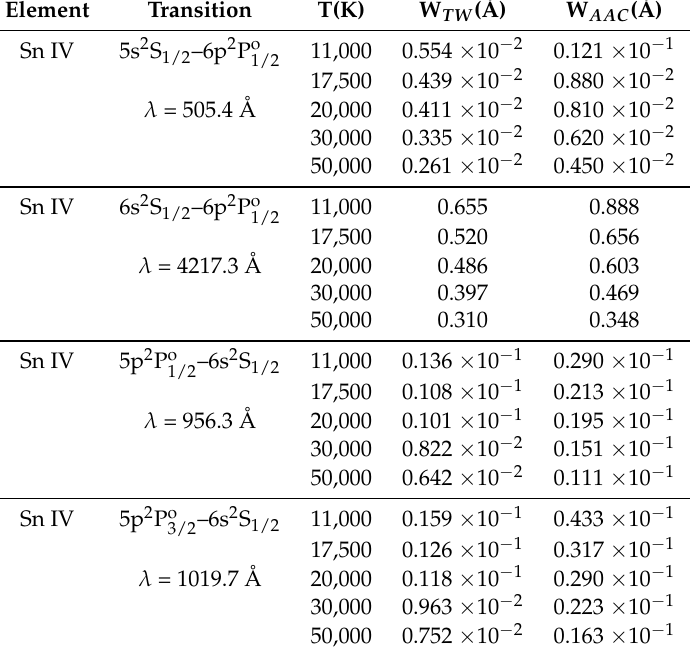
Table 2. Comparison between FWHM - Full Width at Half intensity Maximum (Å) for Sn IV calculated in this work (W TW ) and in de Andrés-García et al. [21] (W AAC ), for a perturber density of 10 17 cm − 3